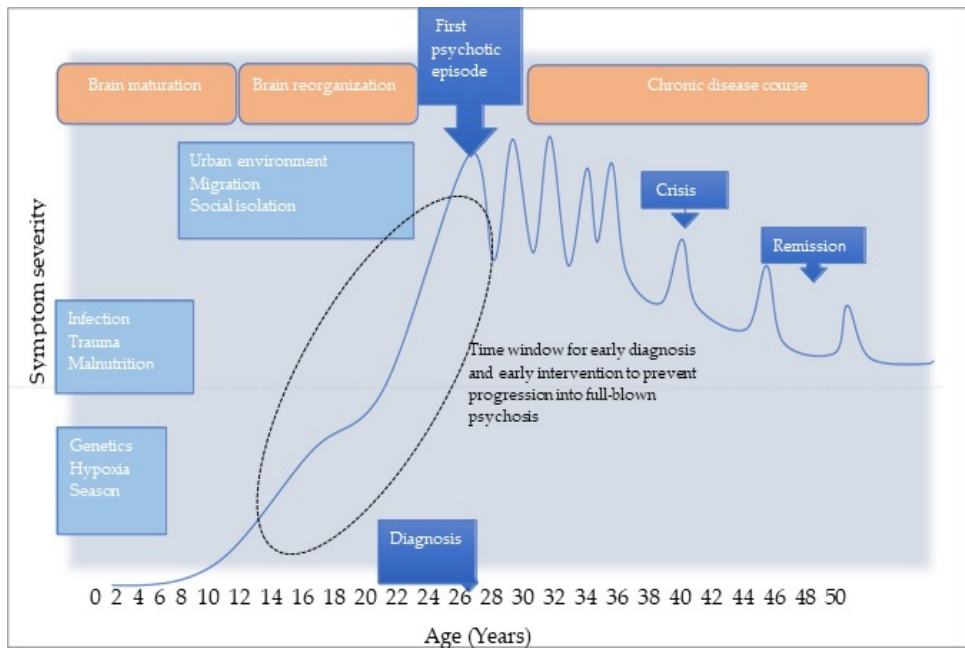
Figure 1. Development and course of psychotic disorders under the influence of environmental stimuli (adapted and modified from Millan et al. [44]).